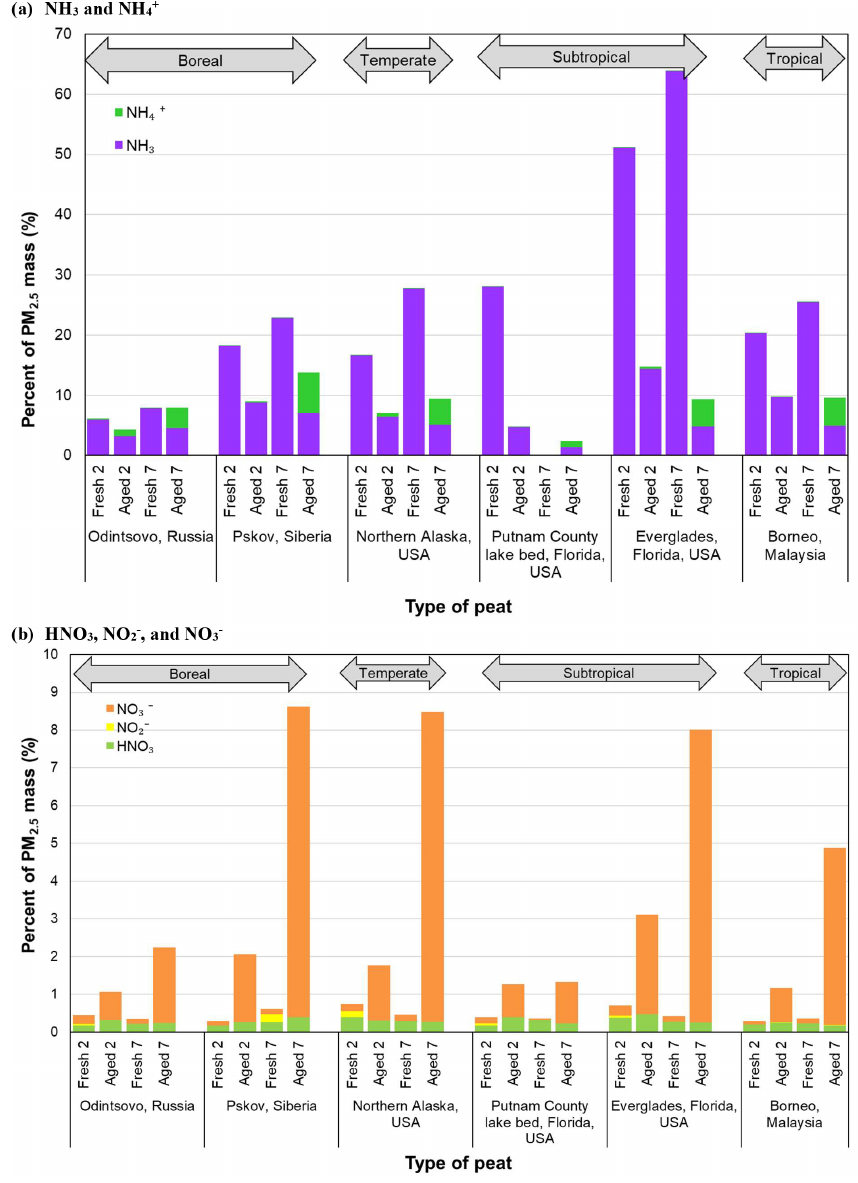
Figure 5. Comparison of nitrogen species for (a) NH 3 and NH + types of